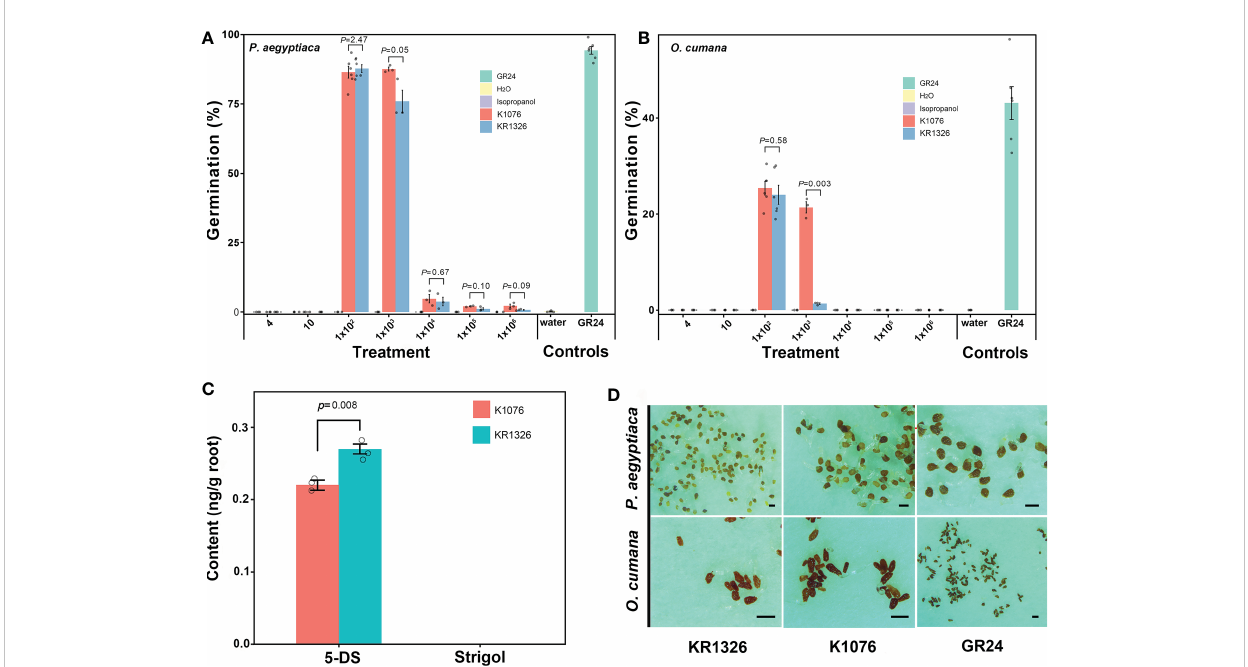
FIGURE 6 Differences in root exudate of susceptible (K1076) and resistant (KR1326) melon cultivars for germination induction of P. aegyptiaca (A) and O. cumana (B) seeds and differences in contents of 5-DS and Strigol in roots (C) . The crude extract of K1076 and KR1326 root exudates was dissolved with 1 ml isopropanol and then diluted with sterile water 4, 10, 1 × 10 2 , 1 × 10 3 , 1 × 10 4 , 1 × 10 5 , and 1 × 10 6 times (n ≥ 3 replicates). Seeds were treated with isopropanol diluted with sterile water at 4, 10, 1 × 10 2 , 1 × 10 3 , 1 × 10 4 , 1 × 10 5 , and 1 × 10 6 times as negative controls. Seeds treated with or without GR24 at 1 × 10 -7 M were always included as positive and negative controls, respectively. (C) Amounts of 5-DS and Strigol (ng/g) in roots (2g) of K1076 and KR1326 obtained in hydroponics (n=3 biological replicates). (D) 1 × 10 2 -time concentrated root exudates from K1076 and KR1326 and GR24 induced germination of P. aegyptiaca and O. cumana. Experiments were repeated at least three times. Scale bar, 500 m m. Vertical bars represent the mean ± SE and P value was conducted by Student t